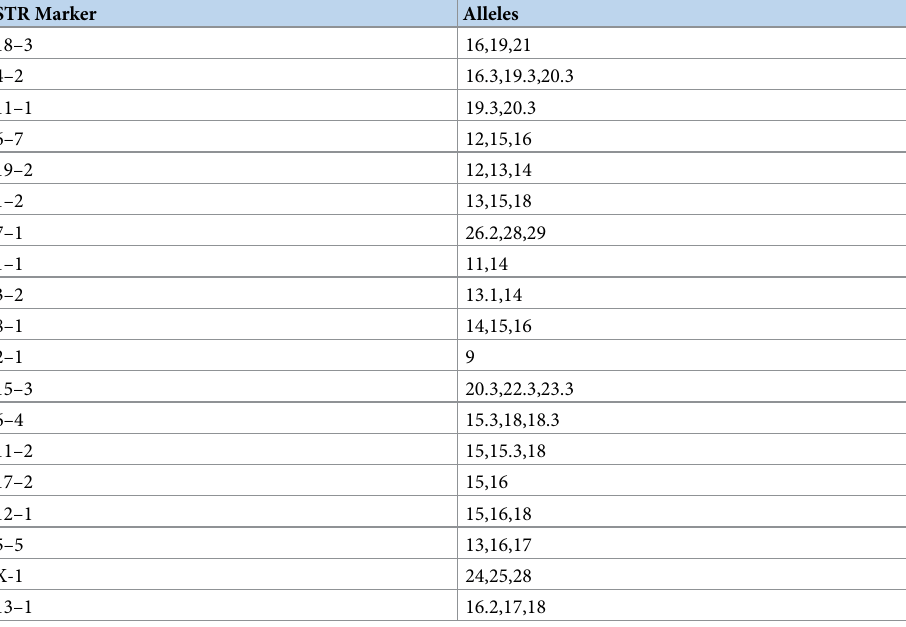
Table 10. STR profile for Calibrant 1